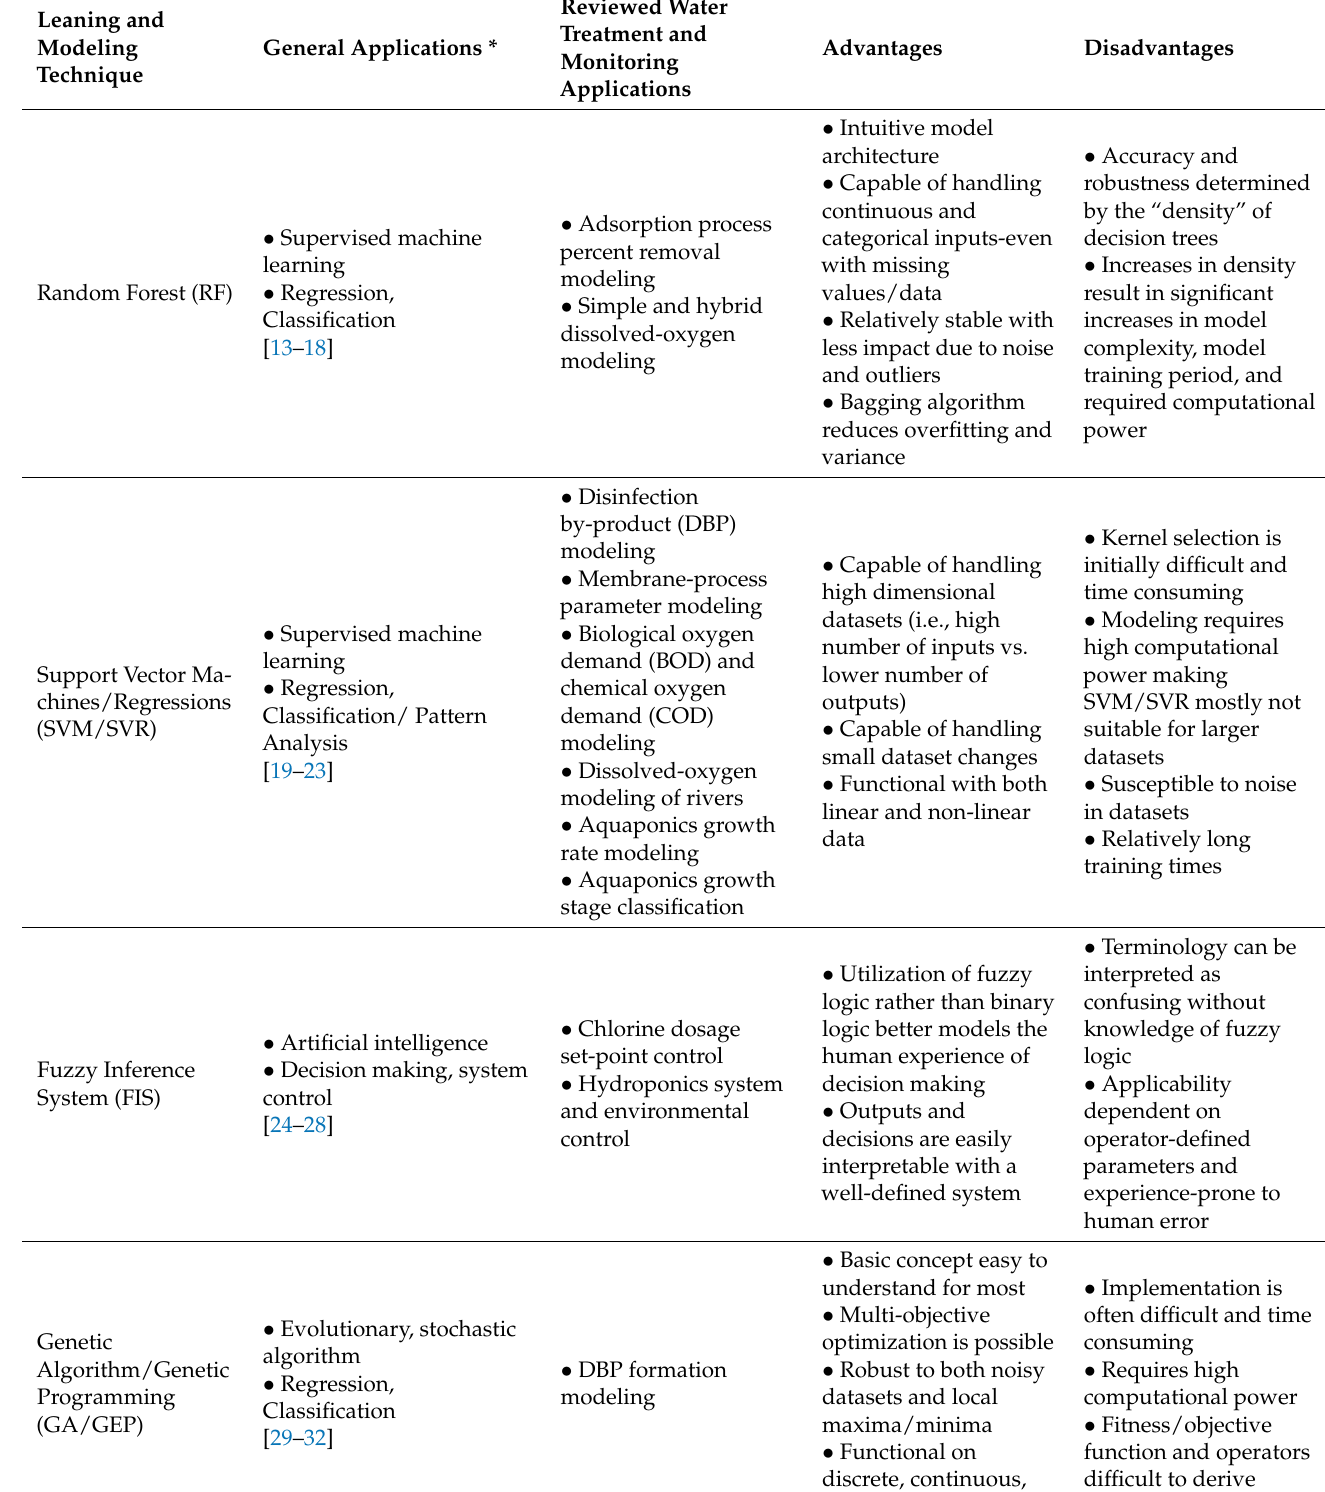
Table 1. A summary of AI methods and ML models used in water treatment and